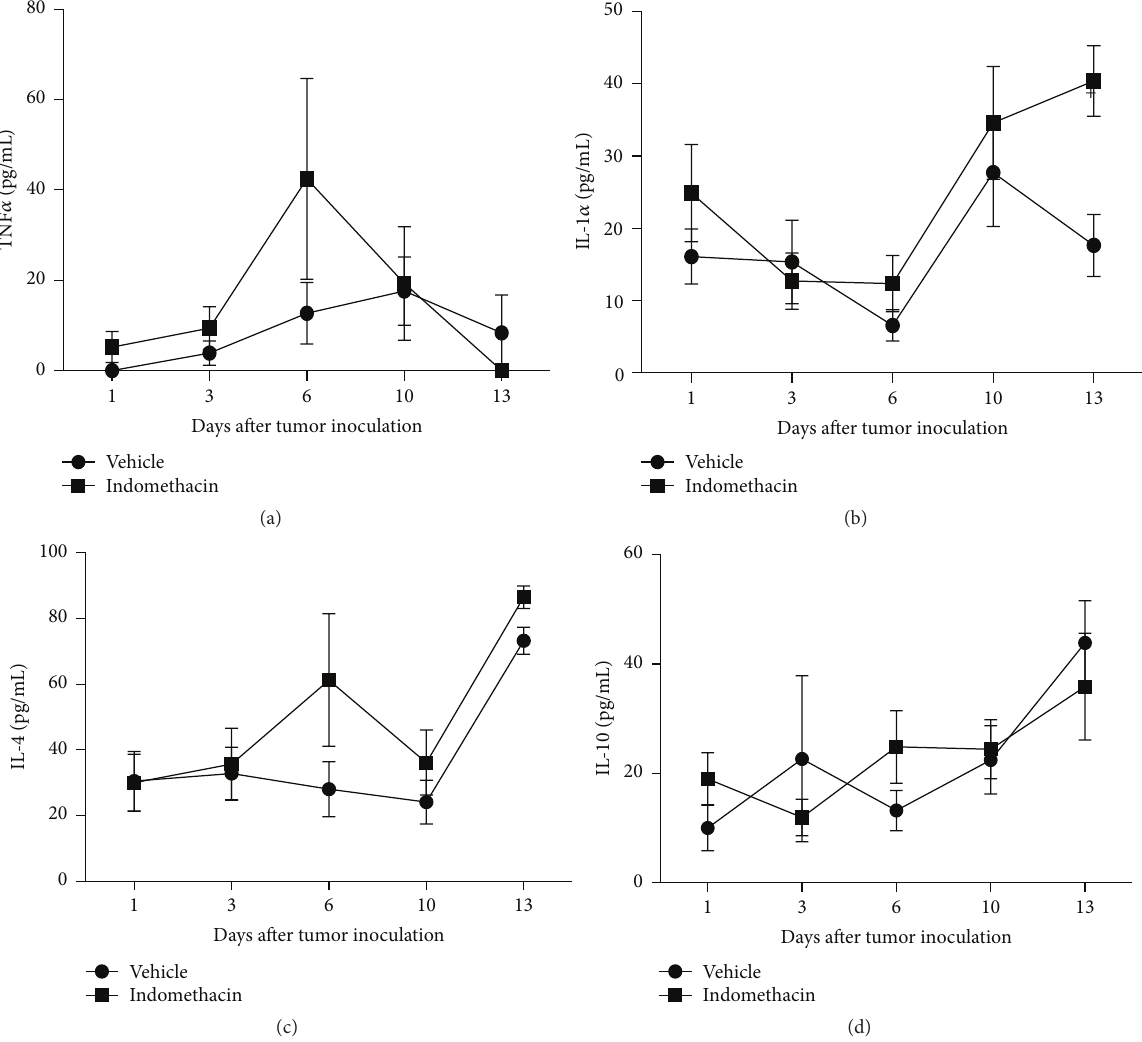
Figure 4: Graphs representing the levels of TNF 𝛼 (a), IL-1 𝛼 (b), IL-4 (c), and IL-10 (d) present in the peritoneal cavity 1, 3, 6, 10, and 13 days after inoculation of 10 3 EAT cells in mice treated with indomethacin (Indomethacin) or diluent (Vehicle). The groups consist of 6 to 21 animals. The graphs represent the median values obtained for the